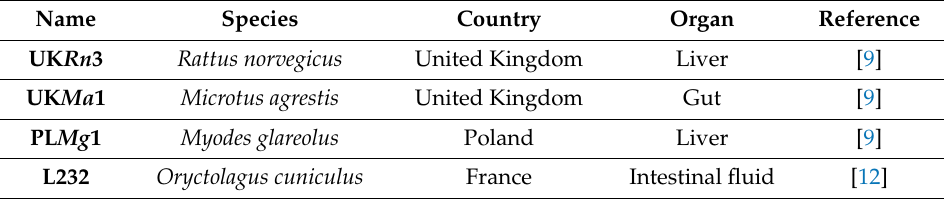
Table 1. List of sample name, species, country of origin, organ, and original